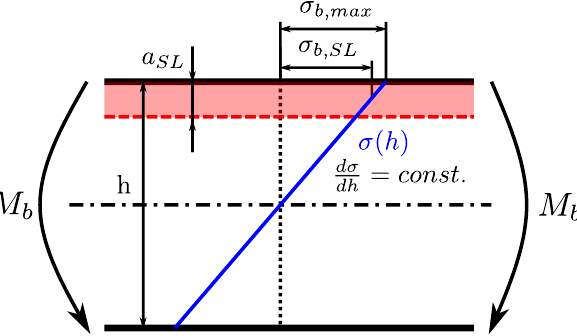
Figure 12. Schematic representation of nominal stress in the surface layer.